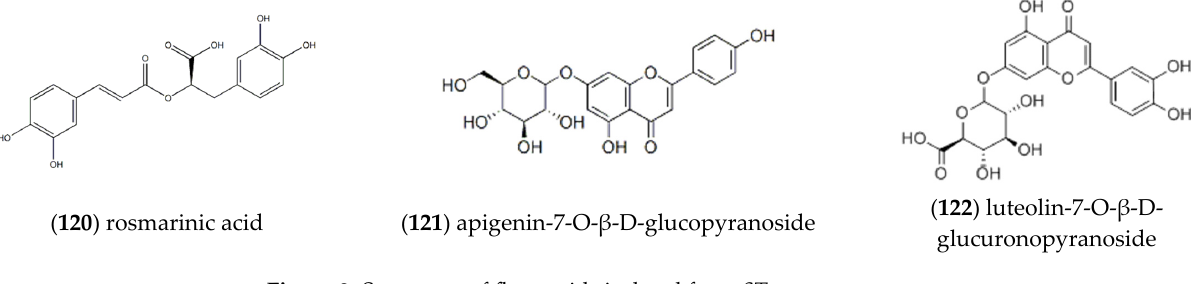
Figure 9. Structures of flavonoids isolated from ST .